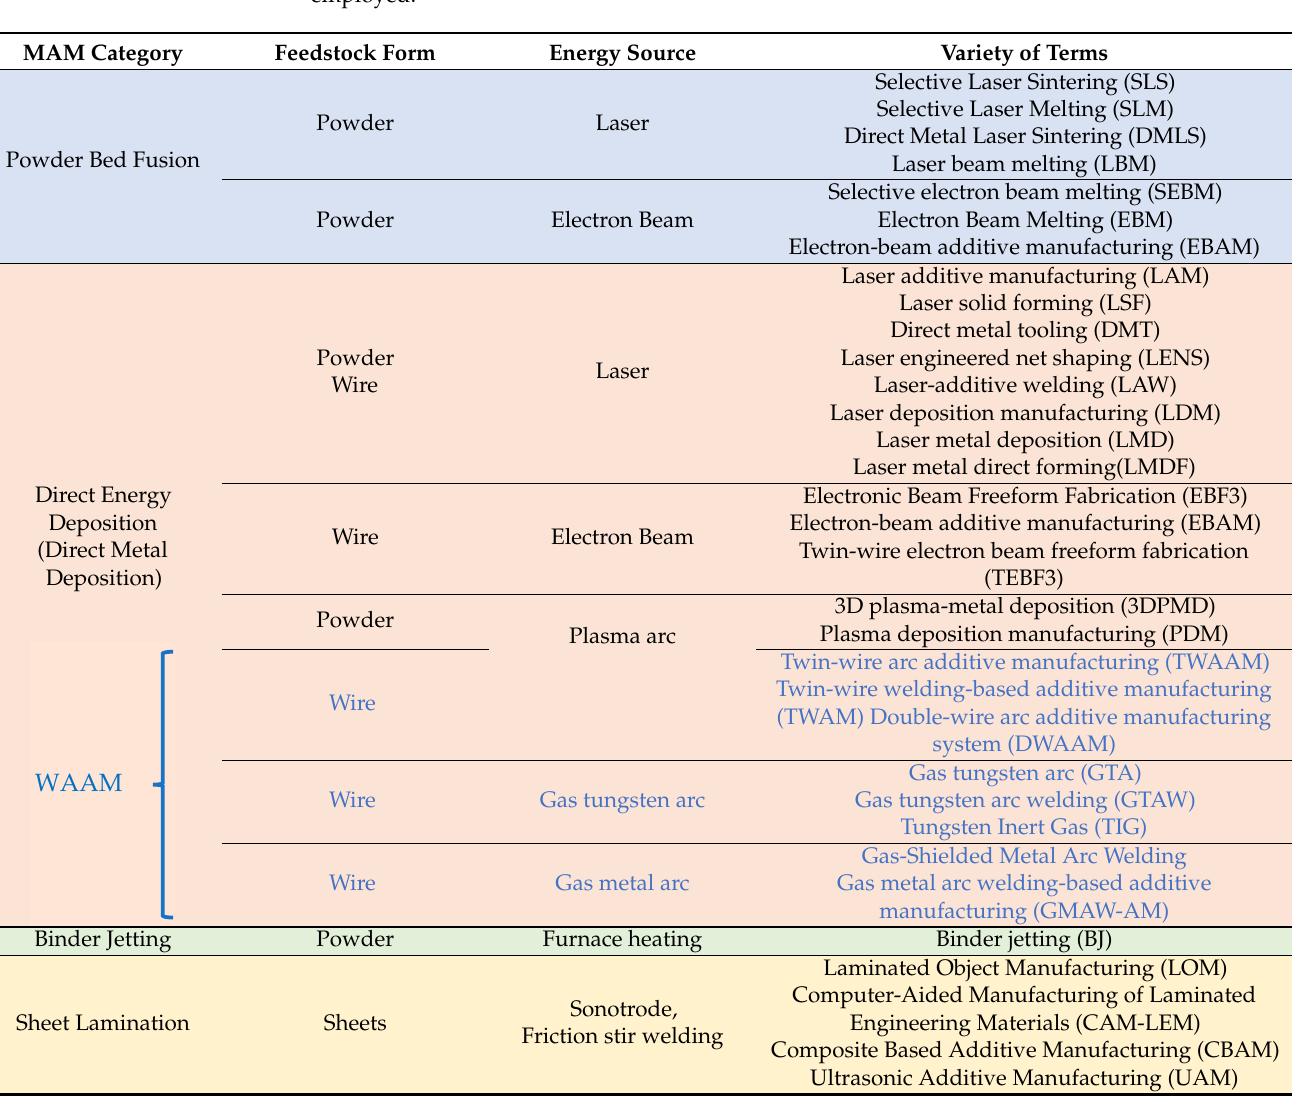
Table 3. Classification of the metal additive manufacturing (MAM) processes based on AM category according to ISO/ASTM 52900–2021, feedstock material and energy source and examples of terms